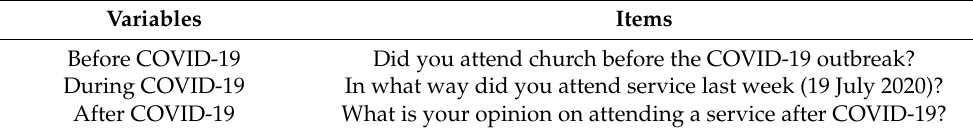
Table 9. Items for in-person service